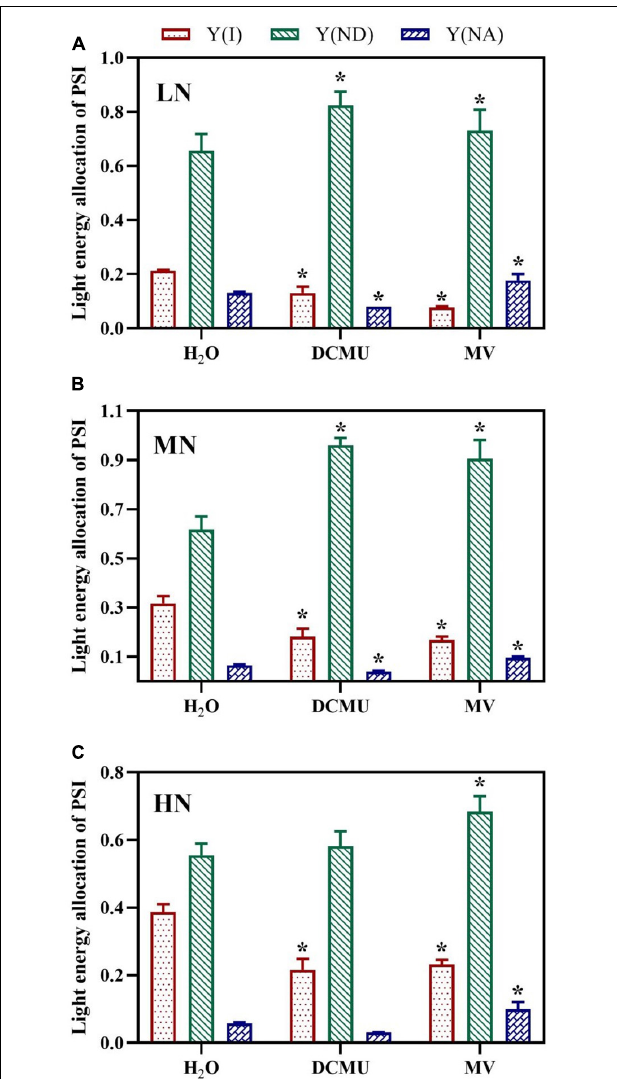
FIGURE 7 | Effects of 3-(3,4-dichlorophenyl)-1,1-dimethyl urea (DCMU) and methyl viologen (MV) on light energy allocation of PSI in Panax notoginseng grown under different nitrogen regimes (light adapted condition). Panels (A–C) represent the nitrogen (N) levels of LN, MN, and HN, respectively. Y(I) is the quantum yield of PSI; Y(ND) is the donor side limitation of PSI; Y(NA) is the acceptor side limitation of PSI. Values for each point were means ± SD ( n = 5). Significant differences are indicated by asterisks (ANOVA; p < 0.05). LN, low N; MN, moderate N; HN, high N; MV, methyl